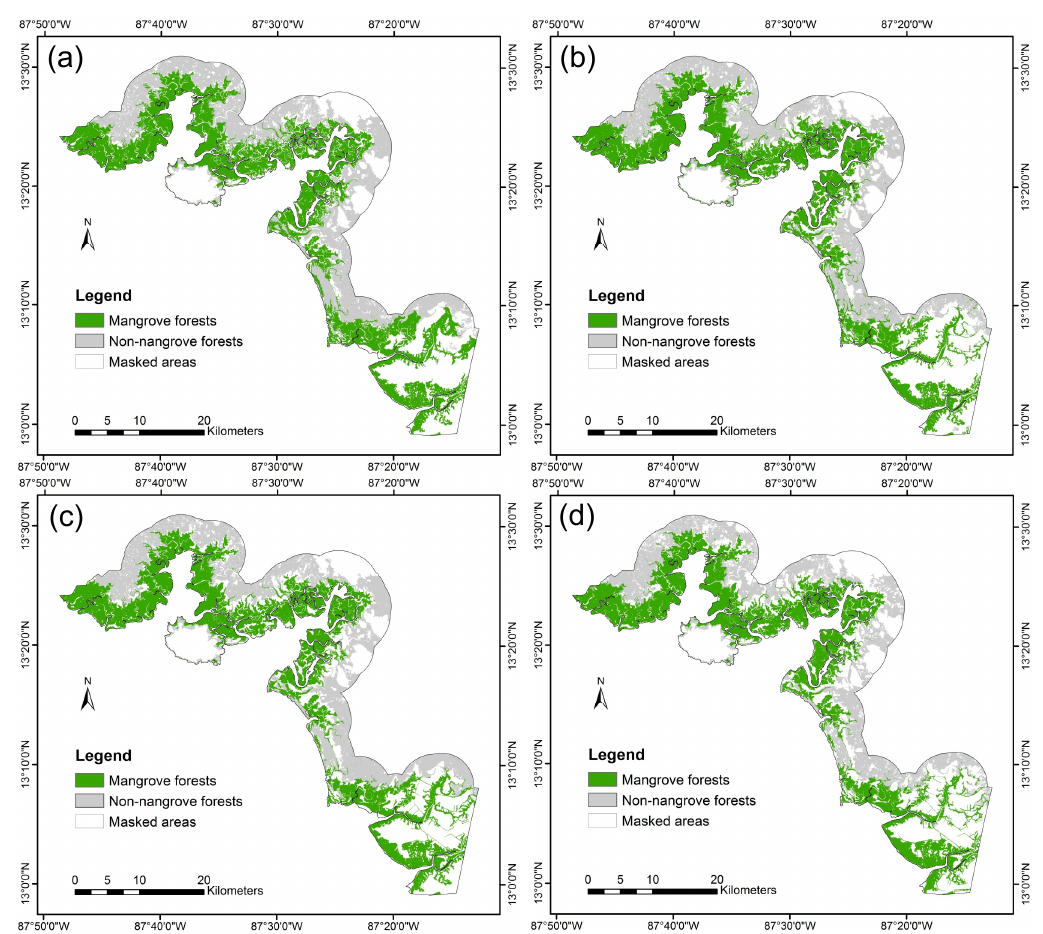
Figure 4. Distribution of mangrove forests in the study area in: ( a ) 1985; ( b ) 1996; ( c ) 2002; and ( d )